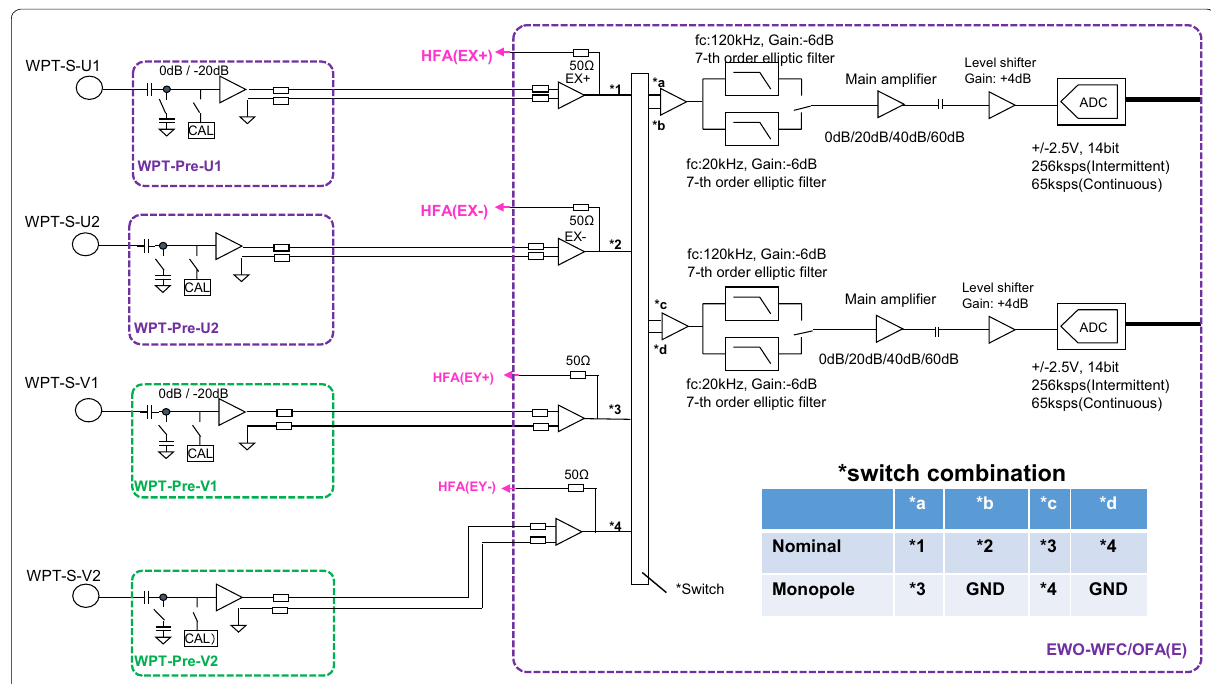
Fig. 8 Simplified block diagram of the WPT and EWO-WFC/OFA(E). Two sets of differential signals between WPT-S-U1 and WPT-S-U2, and WPT-S-V1 and WPT-S-V2 are fed to the WFC/OFA(E) in the “Nominal mode”, while the WPT-S-V1 and WPT-S-V2 are connected to each electric field channel of the WFC/OFA(E) and both are used as monopole antennas in the “Monopole mode”